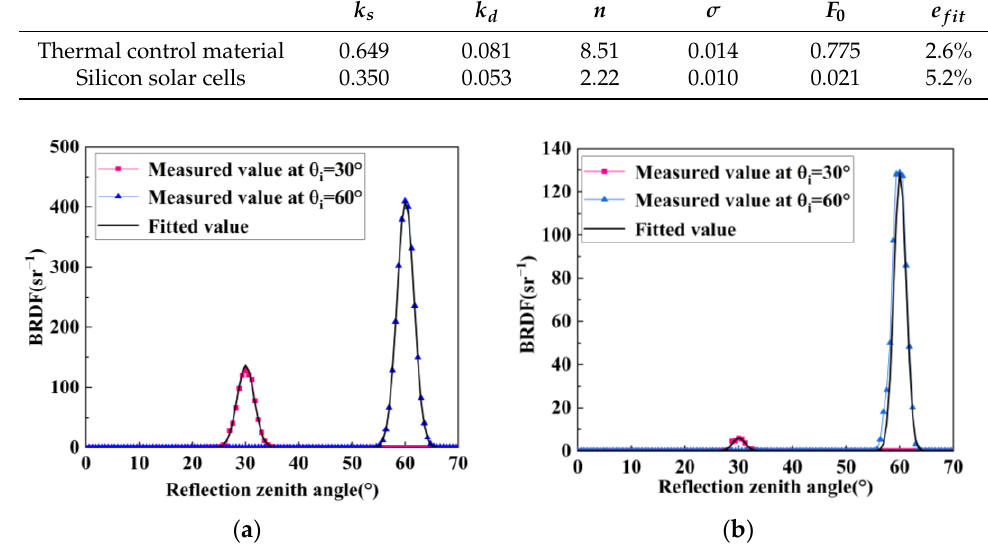
Figure 4. Measurement and model fitting results of BRDF at 850 nm for yellow thermal control material and silicon solar cells. ( a ) Fitting results of the BRDF model of yellow thermal control material; ( b ) fitting results of the BRDF model of silicon solar cells . Table 1. Fitting results of BRDF model parameters at 850 nm.